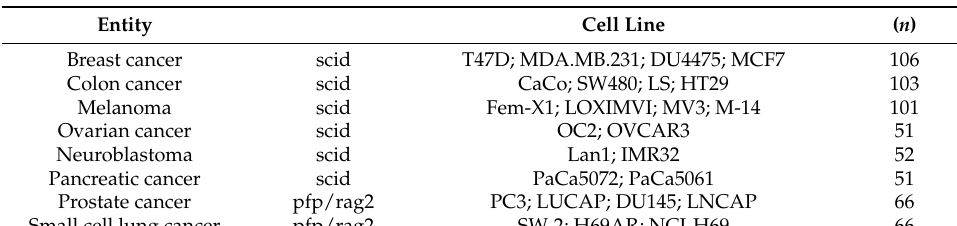
Table 1. Entities of xenograft tumors with their corresponding cell lines. Scid xenograft tumors ( n = 464 slides) and pfp/rag2 ( n = 132 slides).